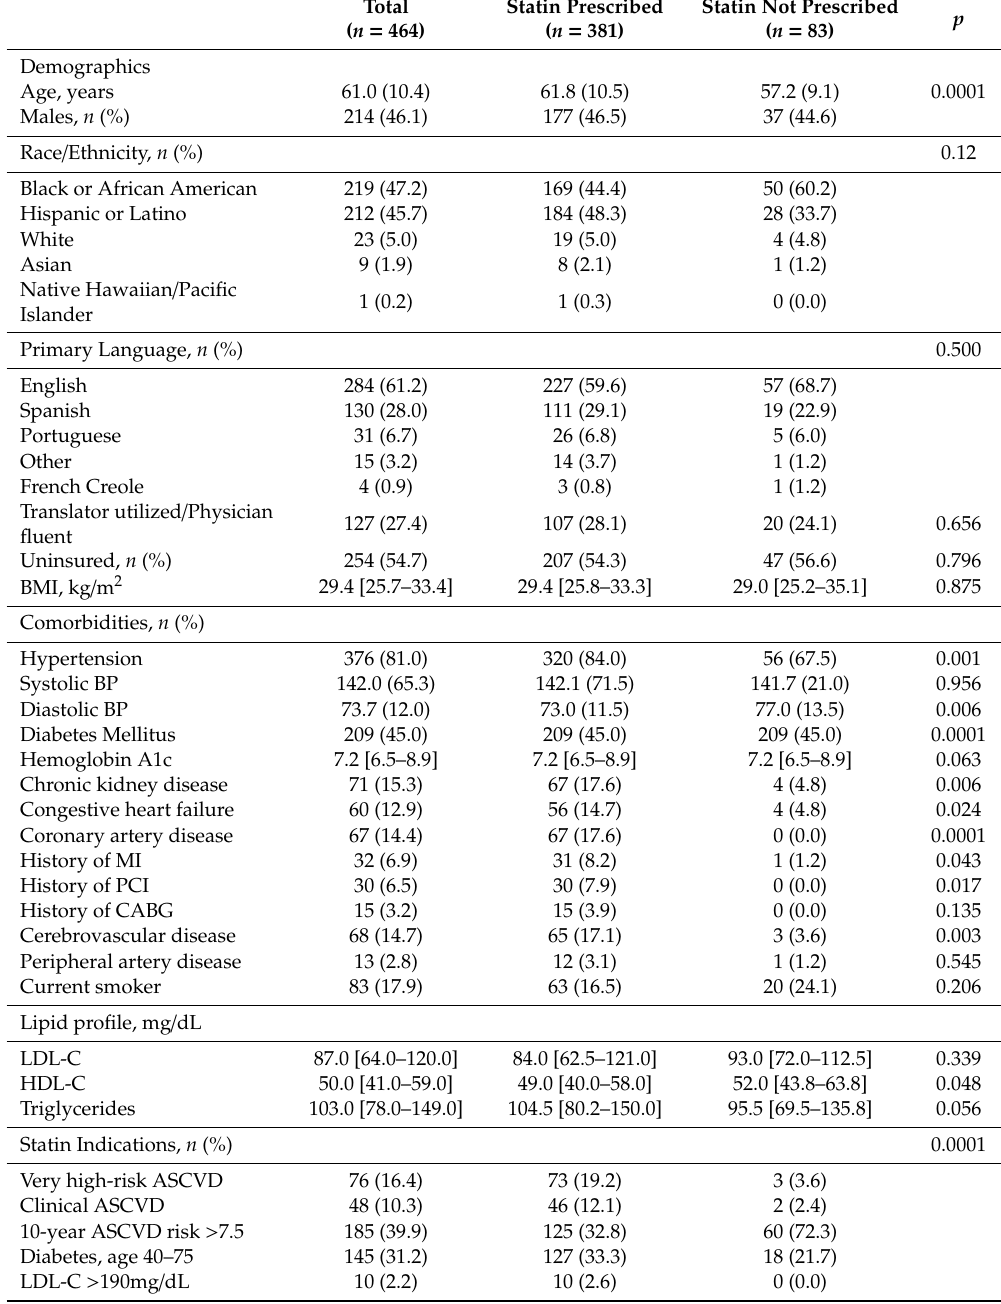
Table 1. Patient